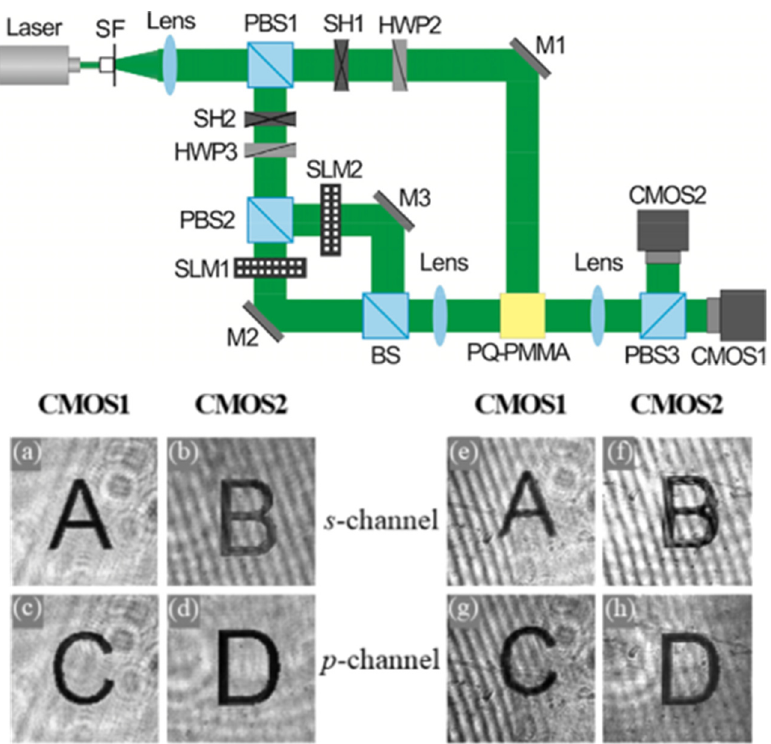
Figure 4. Optical setup of four-channel polarization holographic recording and the experimental reconstructed images [63]. Images reconstructed in four-channel holographic image recording.